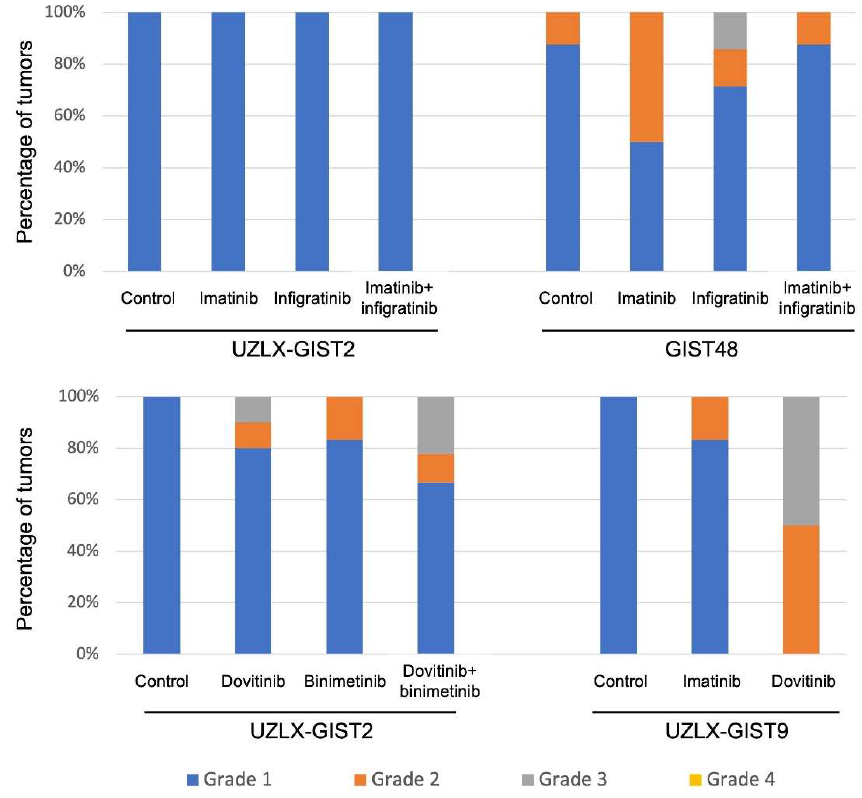
Figure 2. Histological response. Legend: Assessment of histological response graded by assessing the magnitude of necrosis, myxoid degeneration, and/or fibrosis on H&E staining: grade 1 (0–10%), grade 2 (>10% and ≤50%), 3 (>50% and ≤90%), and grade 4 (>90%) [3].